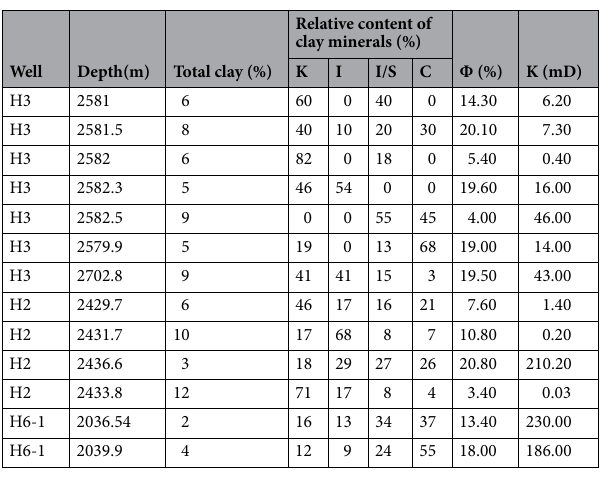
Table 2. Relative content of the clay minerals via XRD and the porosity and permeability of the selected samples. K kaolinite, I illite, I/S mixed layers of illite and smectite, C chlorite, Ф measured porosity, K measured